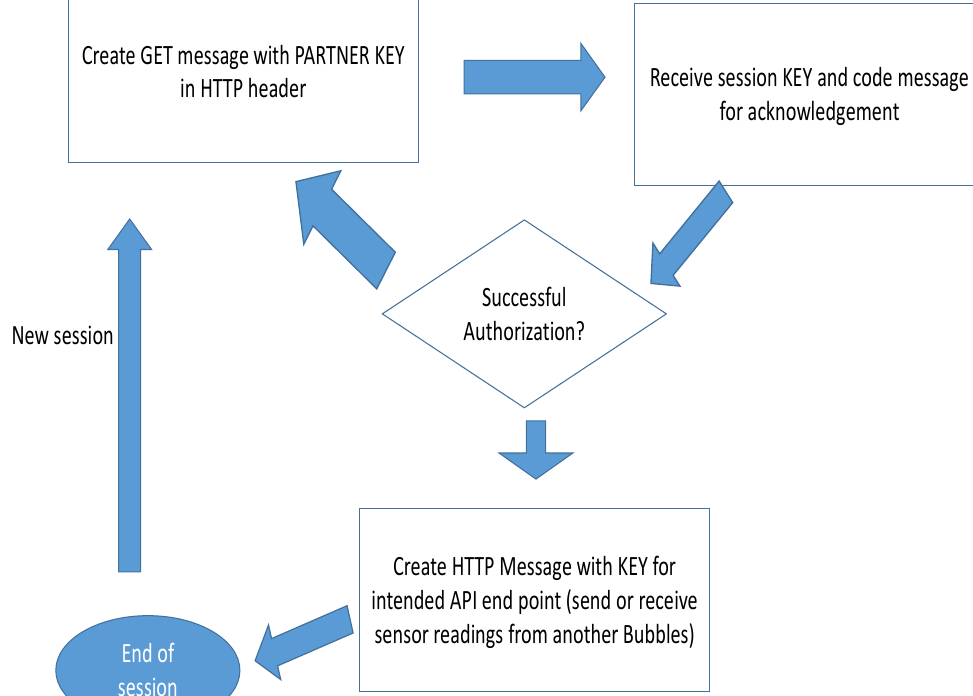
Figure 13. DEWI L2 information model.